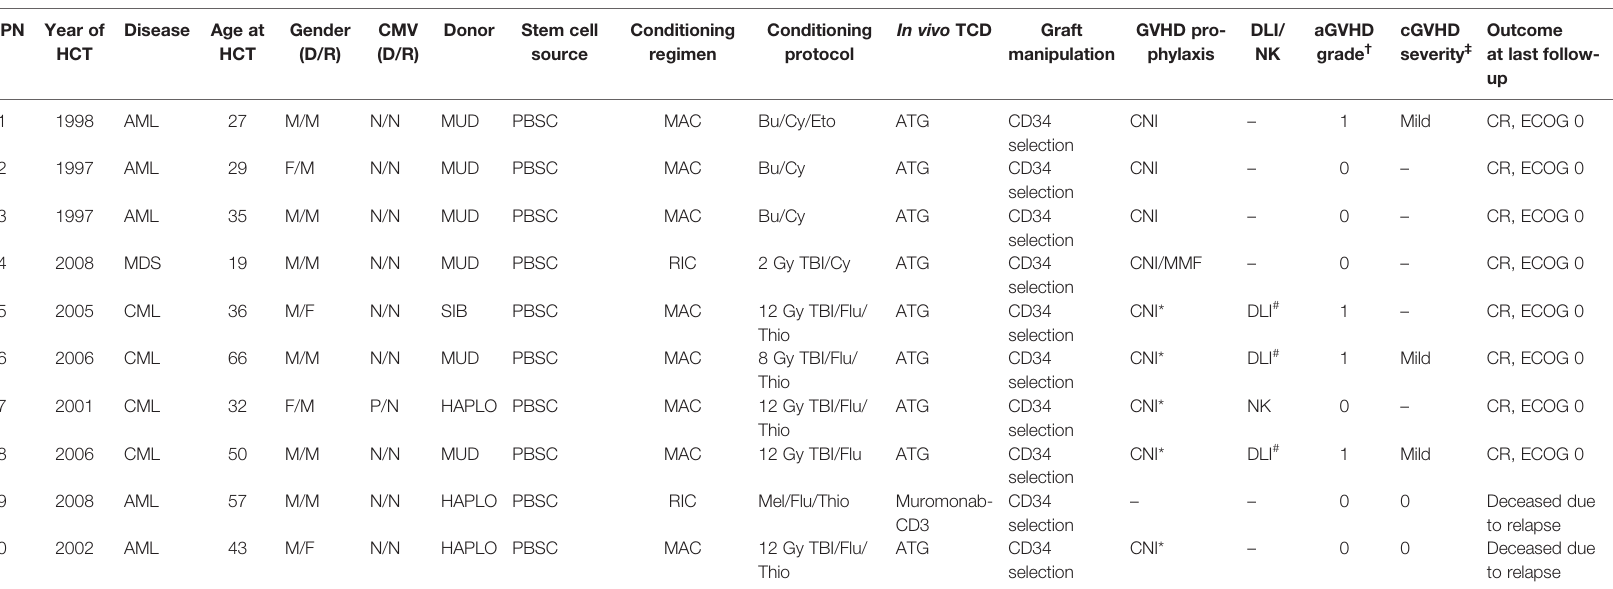
TABLE 1 | Patient and transplant